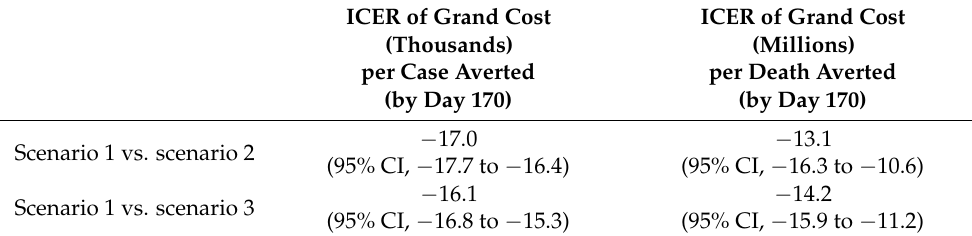
Table 4. ICER of grand cost per case averted and death averted by day 170.